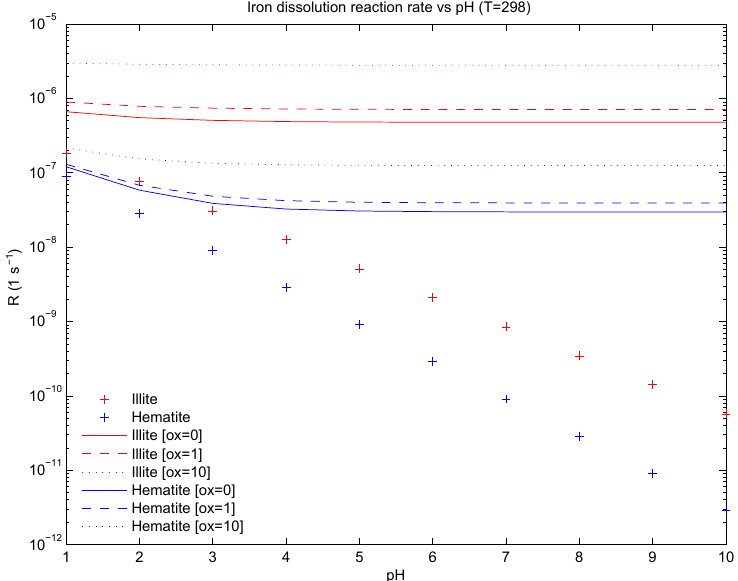
Figure 1. Iron dissolution rate for illite and hematite representing moderately soluble iron and weakly soluble iron, respectively. The “ + ” sign indicates the proton-promoted dissolution rate. Solid, dashed and dotted lines are the addition of the proton-promoted and the oxalate- promoted dissolution rates at [oxalate] = 0, [oxalate] = 1 and [oxalate] = 10µM, respectively.